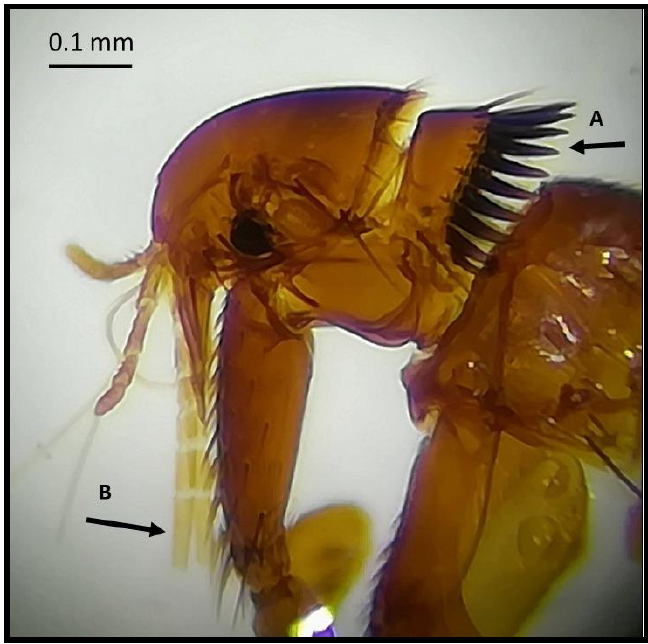
Figure 2. ( A ) Pronotal comb consisting of less than 24 spines; ( B ) labial palp consisting of at least 4 segments and reaching the anterior trochanter as much as possible.